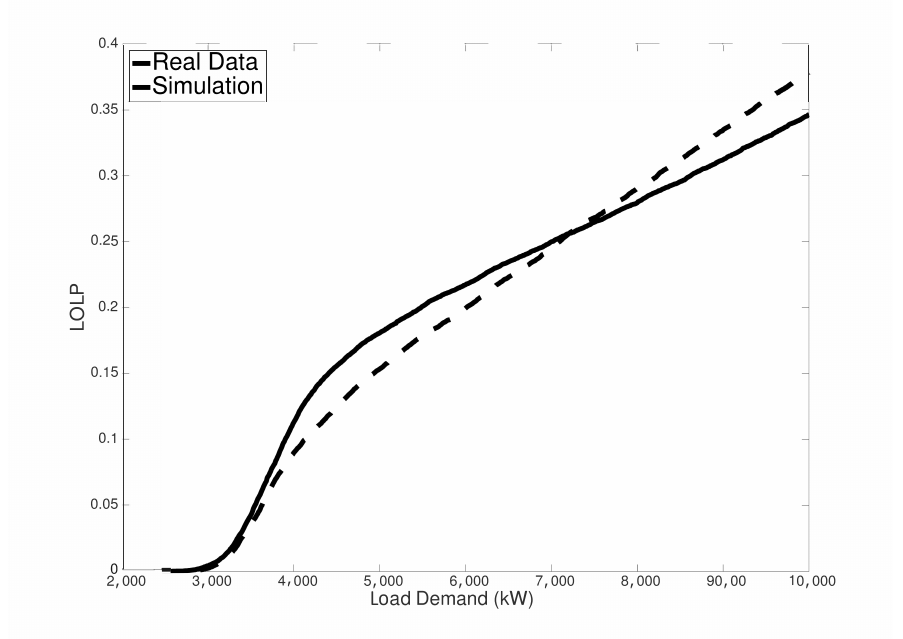
Figure 9. Empirical vs. simulated loss of load probability (LOLP).